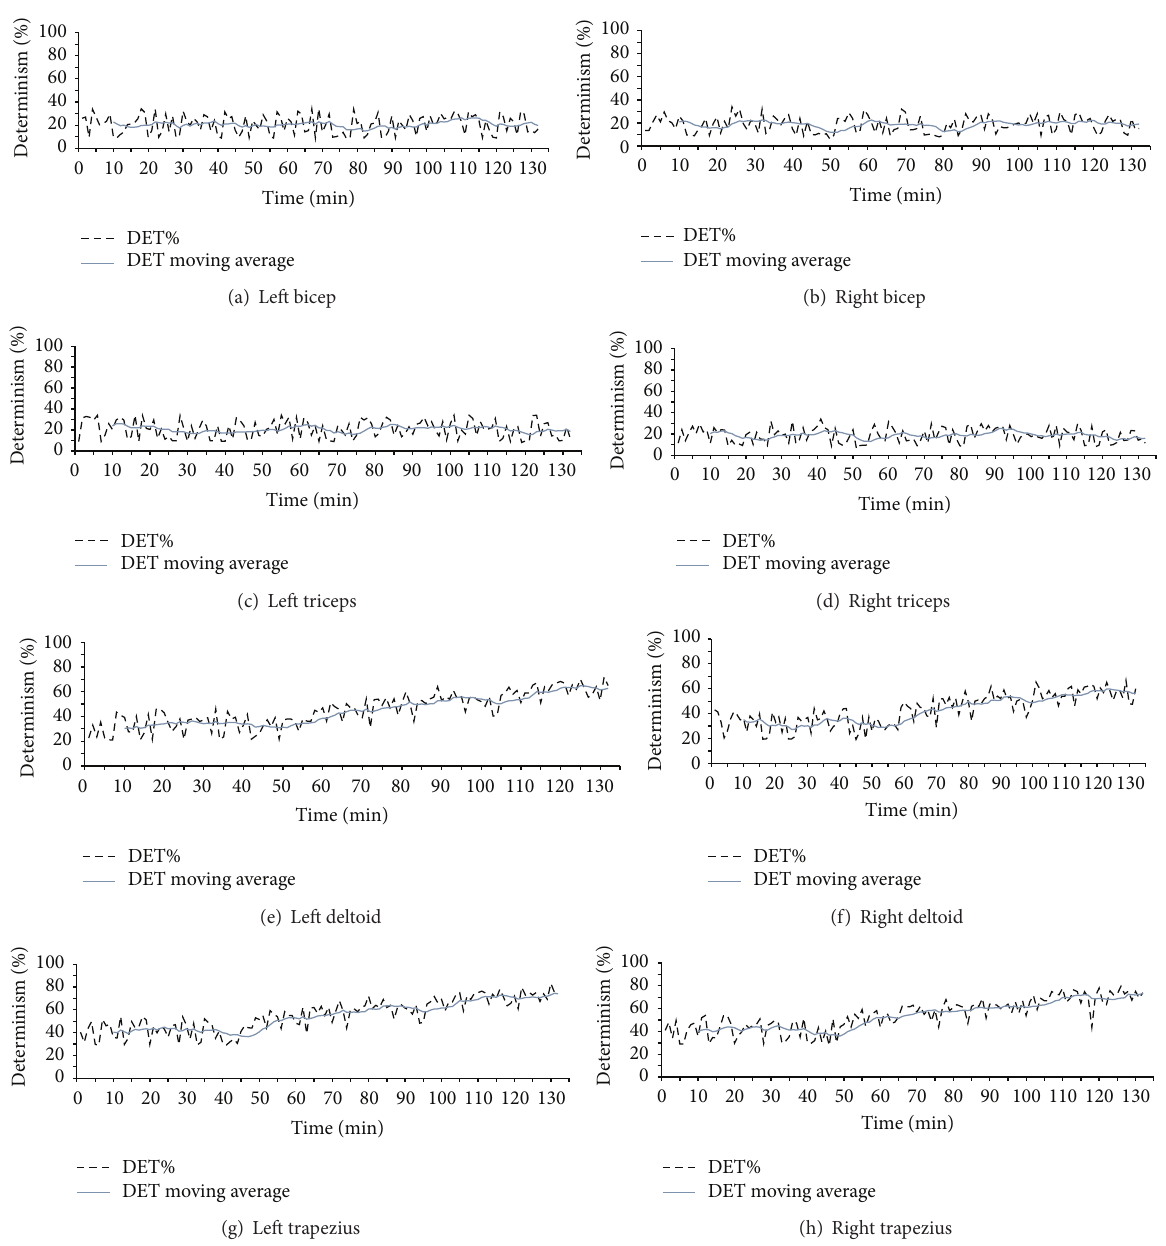
Figure 4: %DET value for all the muscle groups of surgeon 1, case 3. The vertical axis is Determinism % and the horizontal axis is time (min). (a) left bicep, (b) right bicep, (c) left triceps, (d) right triceps, (e) left deltoid, (f) right deltoid, (g) left trapezius, and (h) right